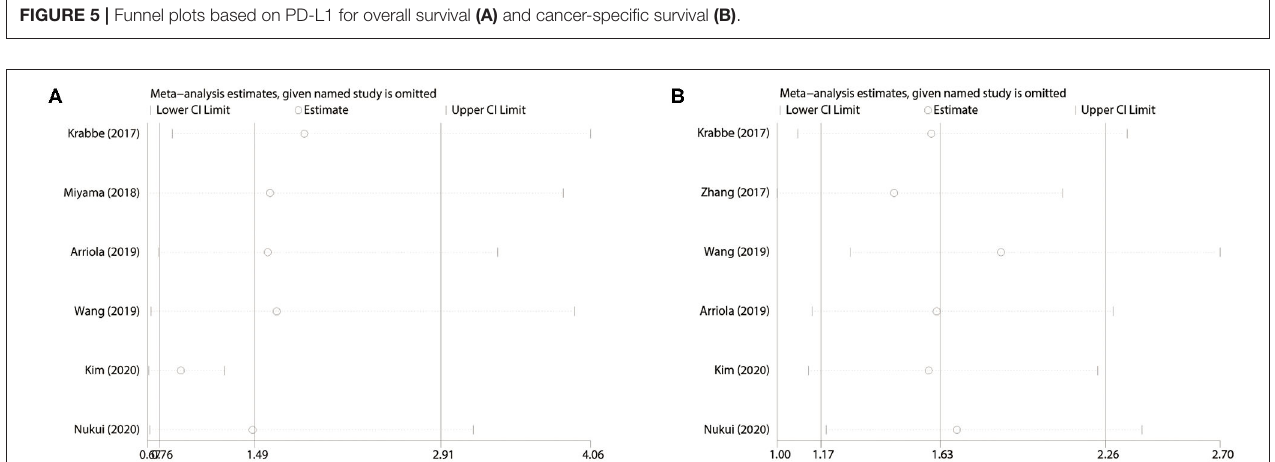
FIGURE 5 | Funnel plots based on PD-L1 for overall survival (A) and cancer-specific survival (B) .